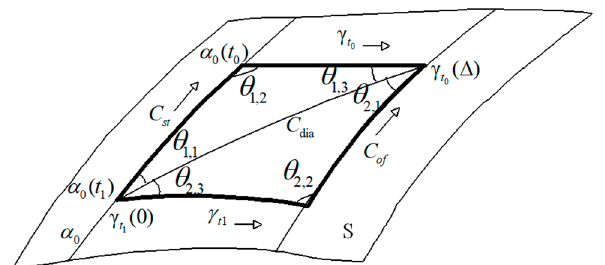
( b ) Figure 5. The Influence of the Relative Position of Geodesic Curve and Surface Boundary on Subsequent Trajectory. 3.2.1. Determining the Relative Position of Initial Trajectory As shown in Figure 6, let a segment on the smooth initial trajectory